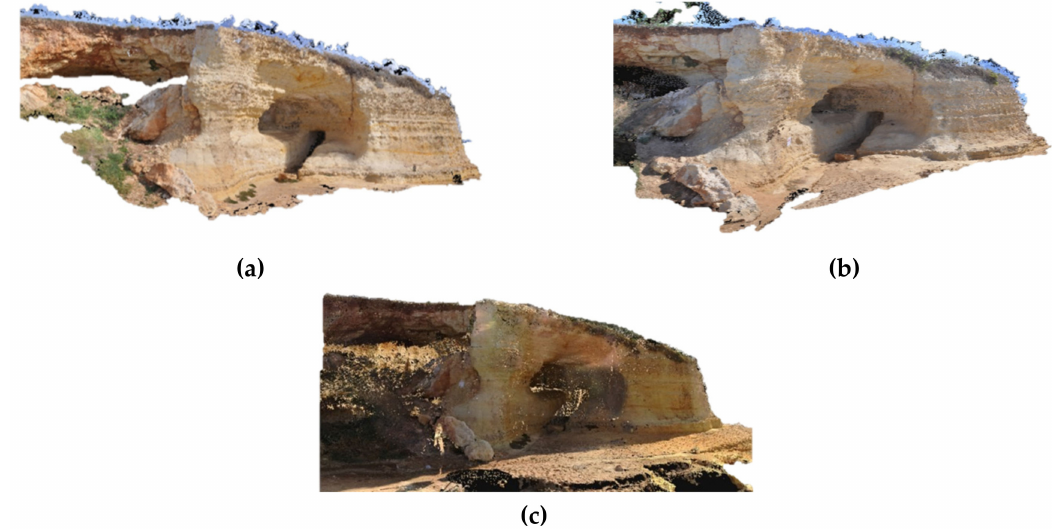
Figure 16. Surveys performed: ( a ) terrestrial photogrammetric survey of 16 March 2019; ( b ) terrestrial photogrammetric survey of 14 September 2019 and 16 June 2020; ( c ) TLS survey of 20 July